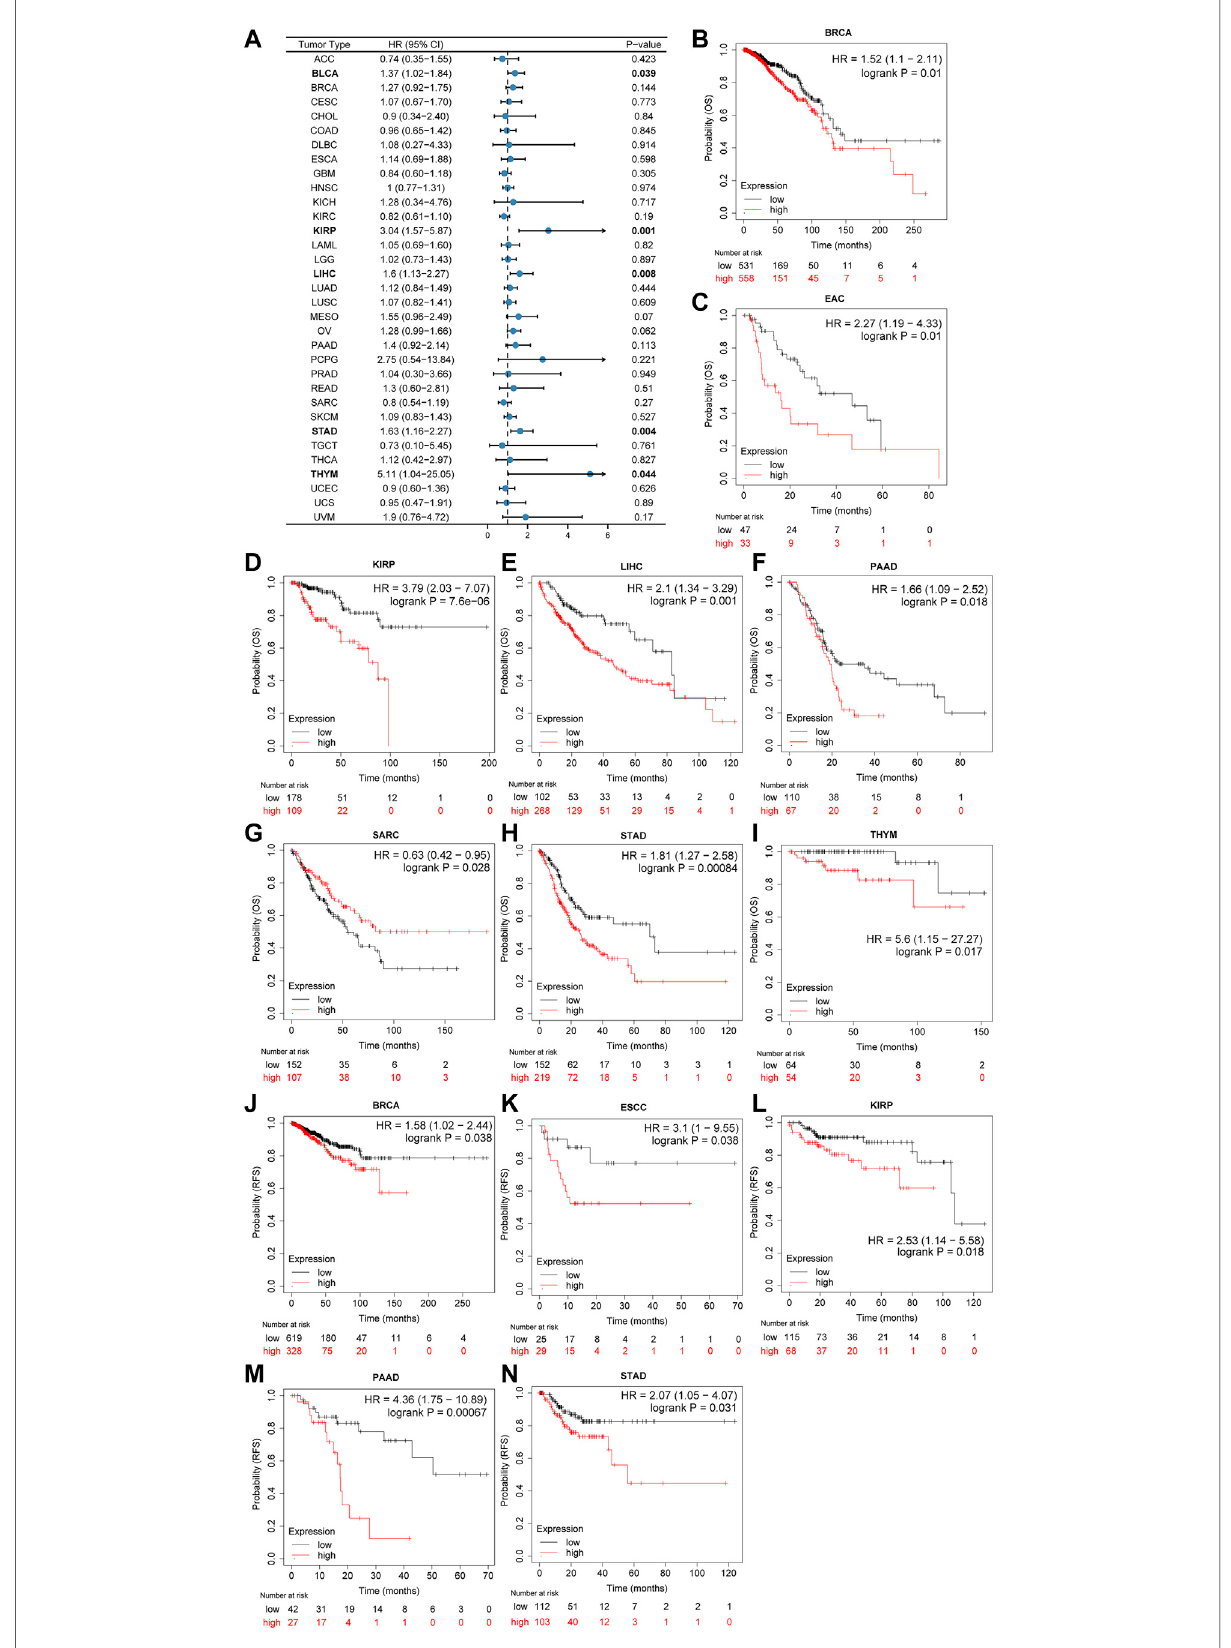
FIGURE 3 Association of prognosis with CSMD2 expression. (A) The forest plots of univariate cox regression analyses for OS. The bold items mean that CSMD2 expression was signi fi cantly correlated with prognosis in these types of cancers ( p < 0.05). (B – I) Kaplan – Meier plots for overall survival.